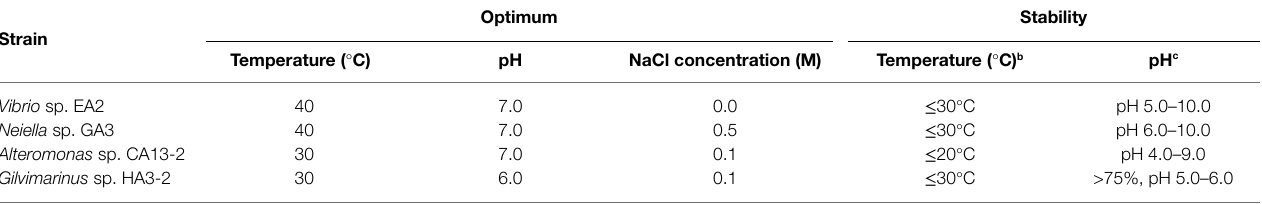
TABLE 4 | Biochemical characterization of the extracellular 1,3-xylanases secreted by Vibrio sp. EA2, Neiella sp. GA3, Alteromonas sp. CA13-2, and Gilvimarinus sp. HA3-2 a .